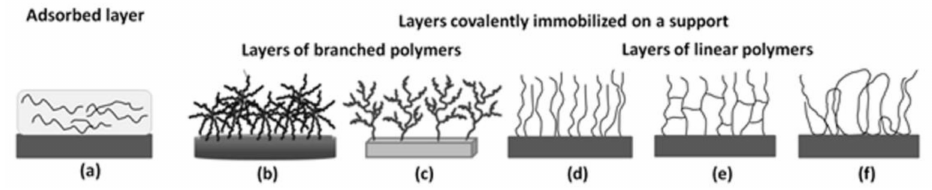
Figure 8. Different kinds of polymer layers immobilized on a support, obtained in the Laboratory of Nano- and Microstructural Materials: ( a ) adsorbed layer, ( b ) layer of star polymer, ( c ) layer of hyperbranched polymer, ( d ) layer of brush structure, ( e ) layers with crosslinked chains, ( f ) layer with interpenetrating polymer